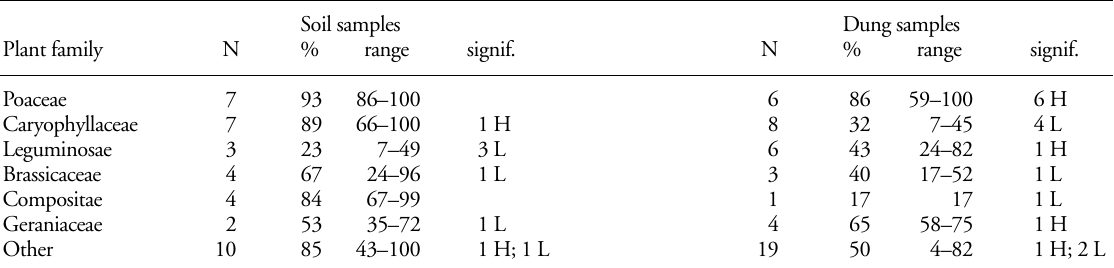
Table 3. Taxonomic differences in the percentage of first-year germination among the most common species in soil and dung samples 1 . Data presented in the table are the number of species in each plant family (N), the mean (%) and range of percentage of first-year germination among them, and the number of species for which it is significatively higher or lower than the mean (signif.; H, high; L, low; U-test p < 0.05 after probability correction, see